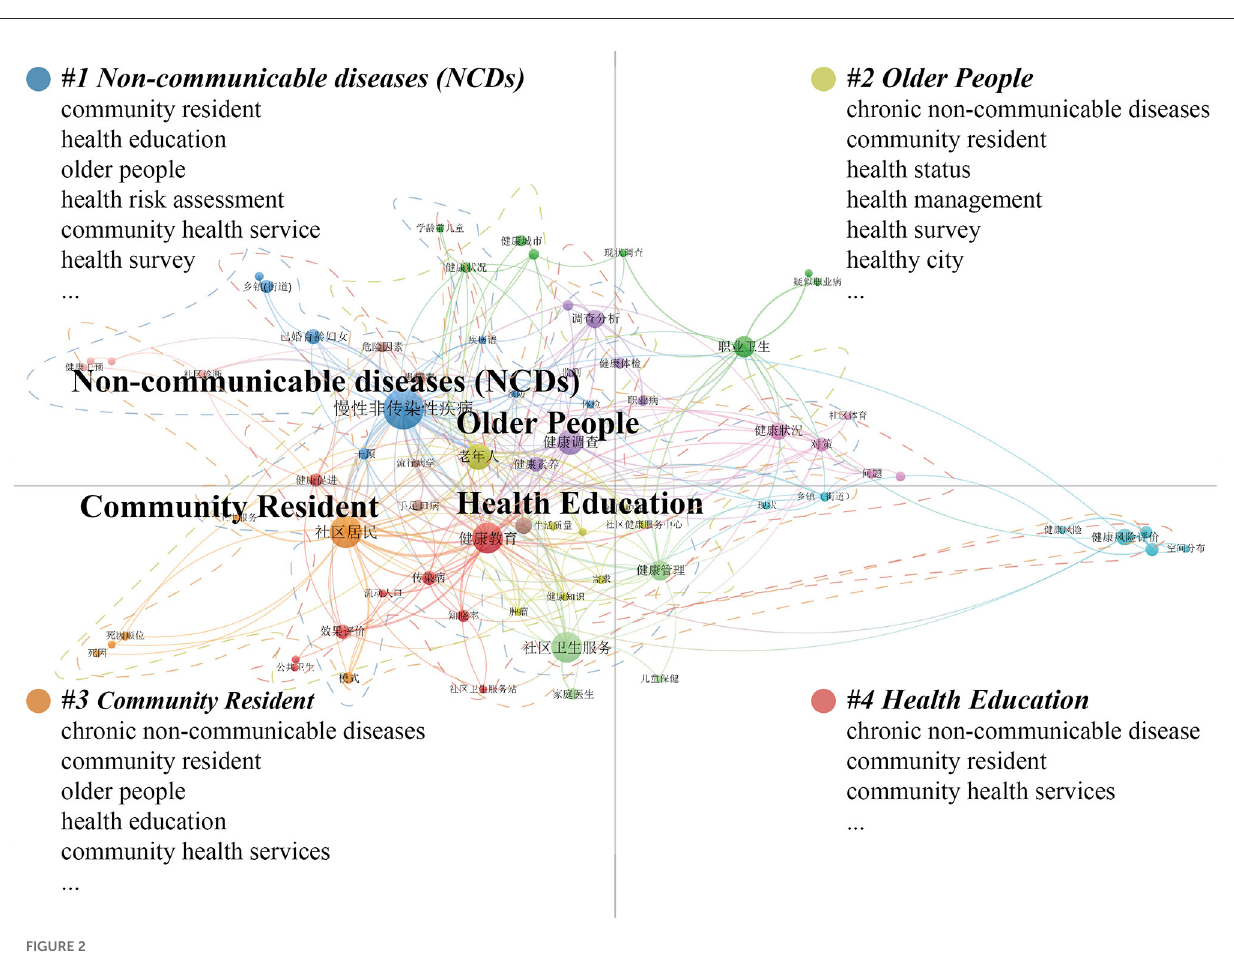
FIGURE2 Major thematic focus areas for